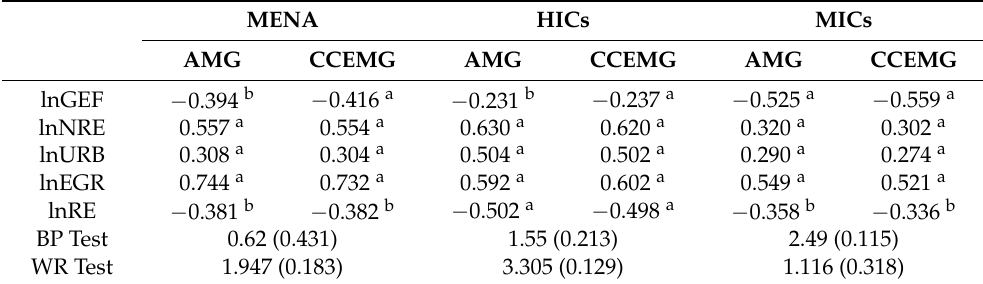
Table 9. AMG AND CCEMG